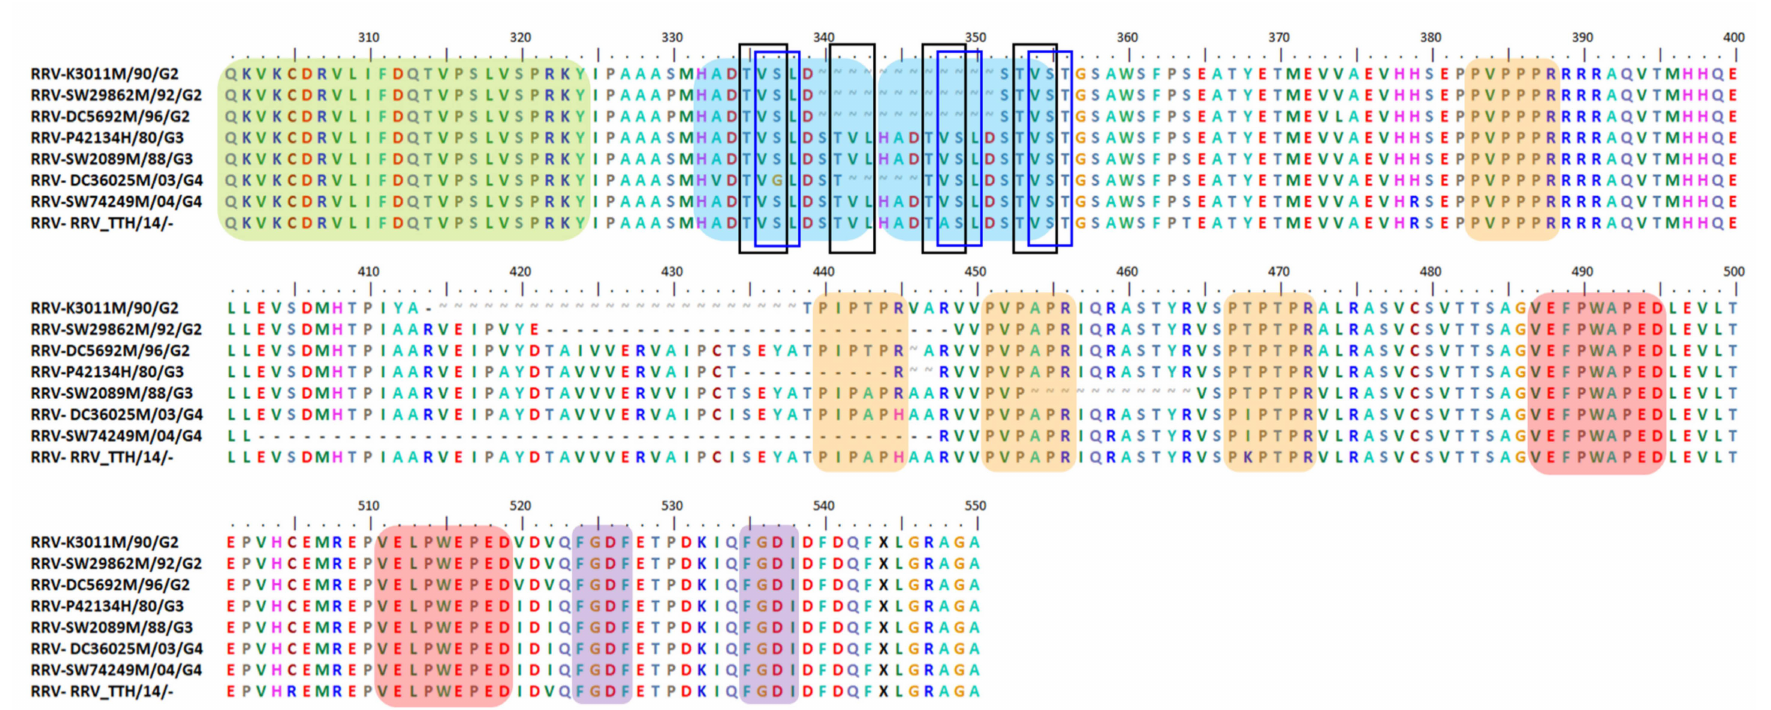
Figure 6. Important motifs and mutation events in RRV nsP3 HVD. The HVD starts at position 325. It has four P-rich regions at positions 383–388, 440–445, 451–456, and 467–472 (peach) as well as two FGDF-like motifs at positions 524–527 and 535–538 (purple). There are 1–45 aa deletions, starting at position 403–464, which mostly abolished half of or the entire second or third P-rich regions of the selected strains, such as SW29862, P42134, SW2089, and SW74249. It also has duplication motifs of VE(F/L)PW(A/E)PED at positions 487–495 and 511–519 (red), and the HADT(V/A)(S/G)LDSTV(L/S) duplication motif in blue boxes at positions 332–343 and 344–355 (blue). Meanwhile, another study suggested that despite having duplication events at positions 332–343 and 344–355, there was a 12 aa insertion in the STVLHADT(V/A)SLD at position 340–351. Notably, there are four duplicates of T(V/A)(S/G/L) at positions 335–337, 341–343, 347–349, and 353–355 (black boxes). There is also a short motif that is possibly conserved/inserted/repeated among RRV strains, (V/A)(S/G)(L/T), at positions 336–338, 348–350, and 354–356 (blue